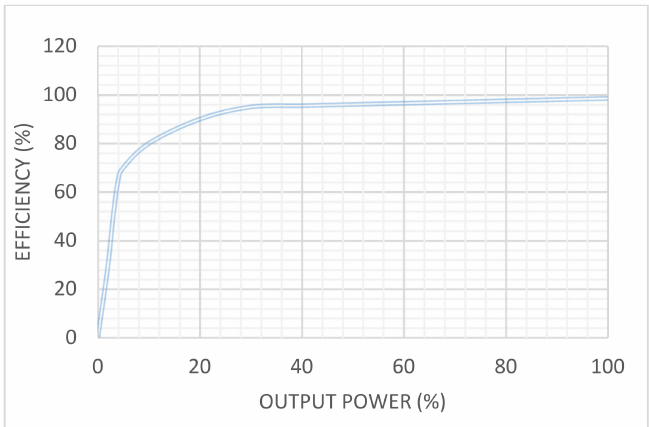
Figure 3. Typical inverter efficiency